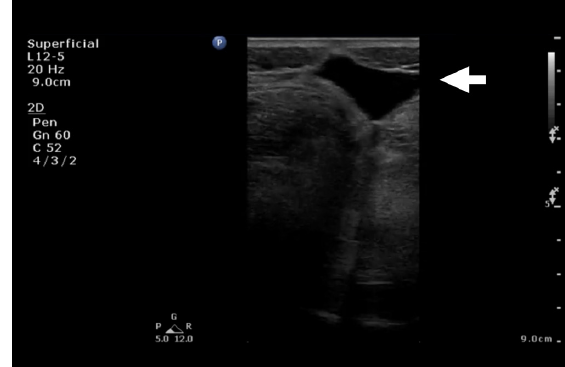
Image 1. Sagittal ultrasound image of a simple fluid collection (arrow) tracking from the skin to the spine.